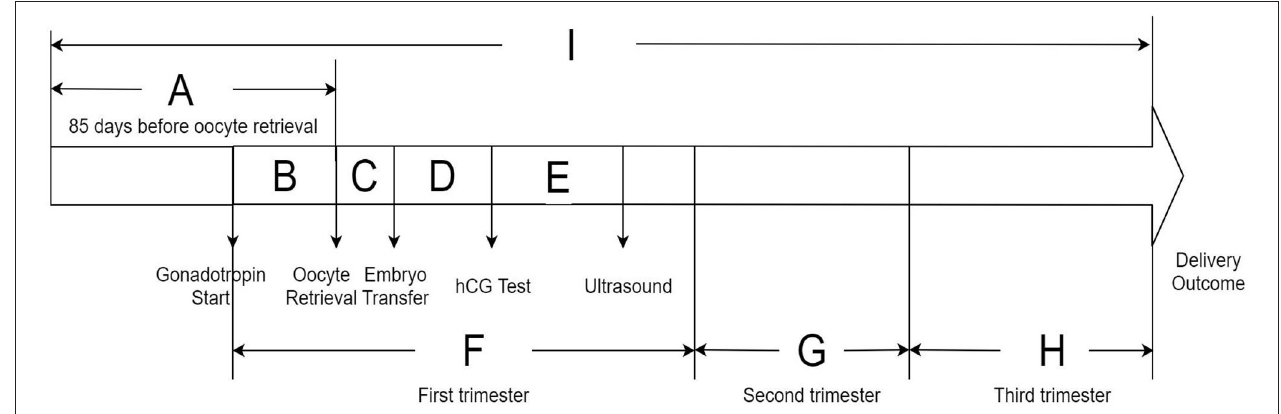
FIGURE 2 | Timeline of exposure windows during a fresh in vitro fertilization cycle.